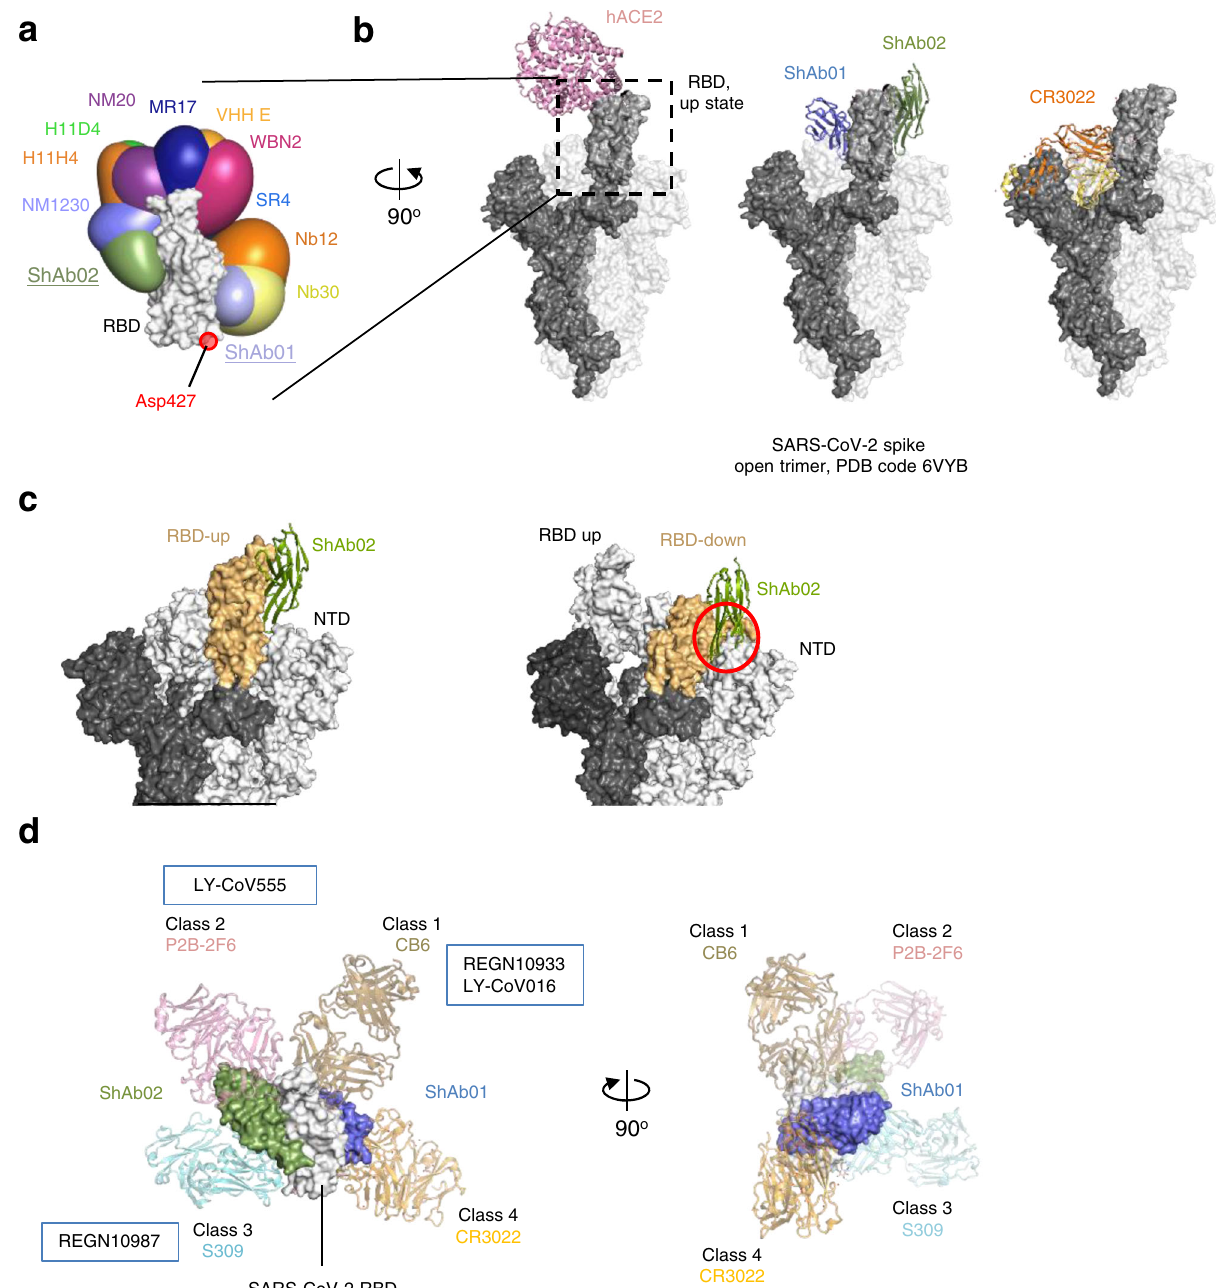
Fig. 5 | Crystal structure of ShAb01 and ShAb02 in the context of prefusion S. a SARS-CoV-2 RBD (light gray) is shown in surface representation, with ShAb01, ShAb02, and 10 other nanobodies overlaid and shown in smooth surface repre- sentation. b StructurealignmentoftheShAb01-ShAb02-RBDcomplex(center)toa partially open S-2P structure(1-RBD-up conformation, PDB ID:6VYB). Both ShAb01 and ShAb02 have full access to their respective epitopes in this structure. ACE2 (left) and CR3022 (right) are shown for reference. c The SARS-CoV-2 spike is